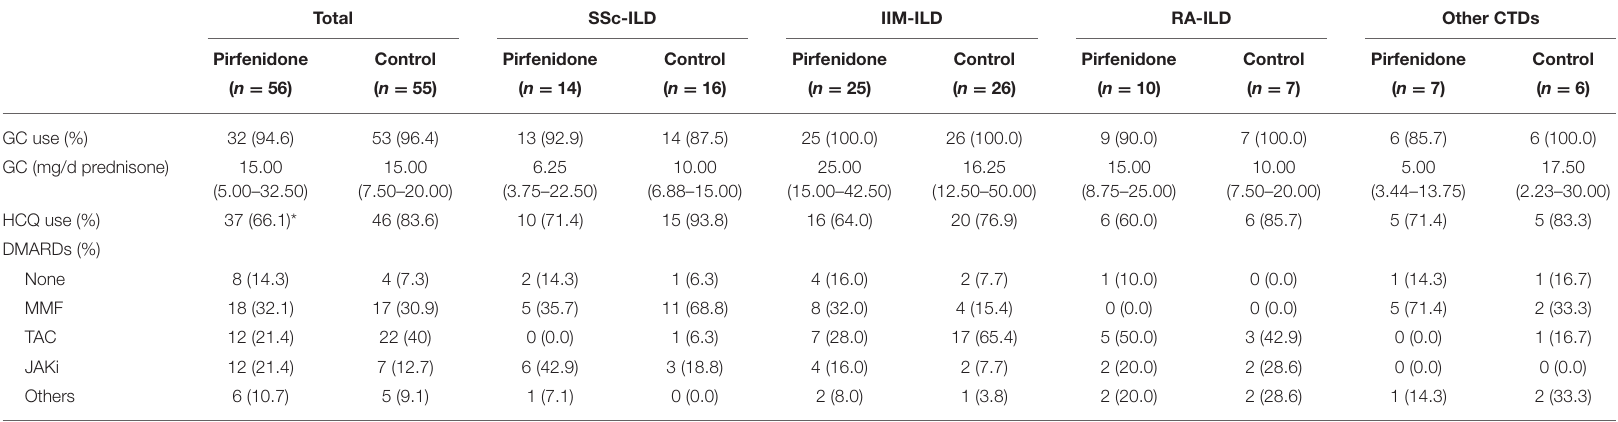
TABLE 2B | The baseline therapeutic regimen in PFD-treated and control groups of patients with